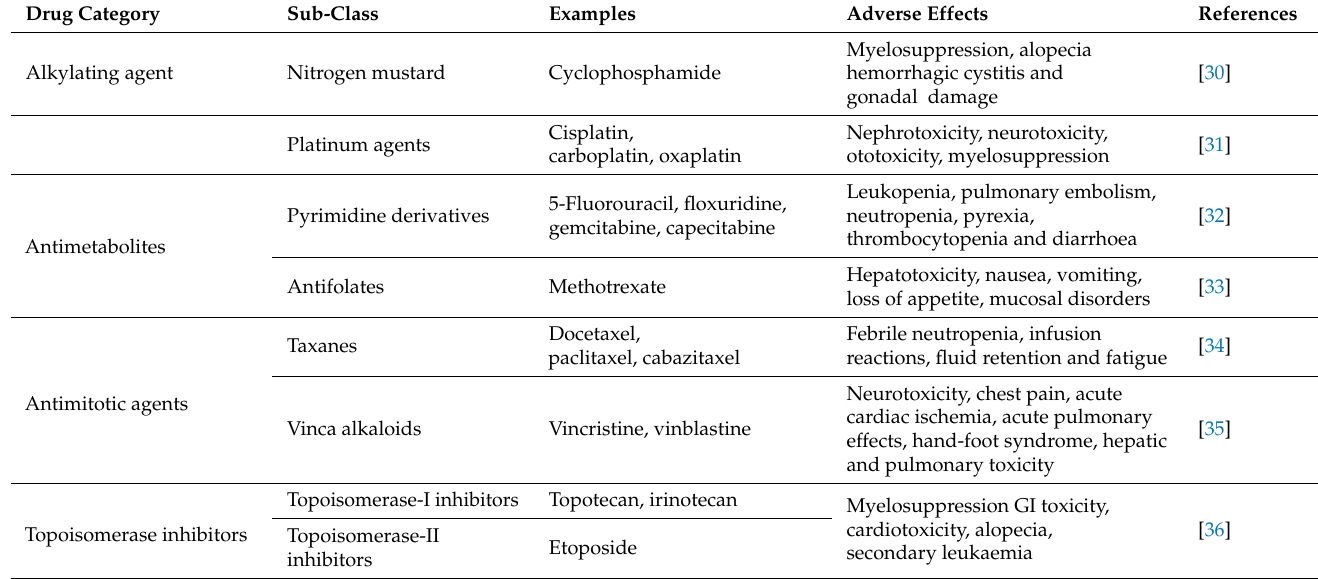
Table 1. List of anticancer drugs along with their adverse